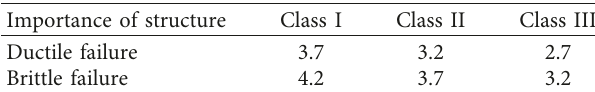
Figure 16: Reliability index and degradation depth at different service time. Table 5: Target reliability index of bearing capacity limit